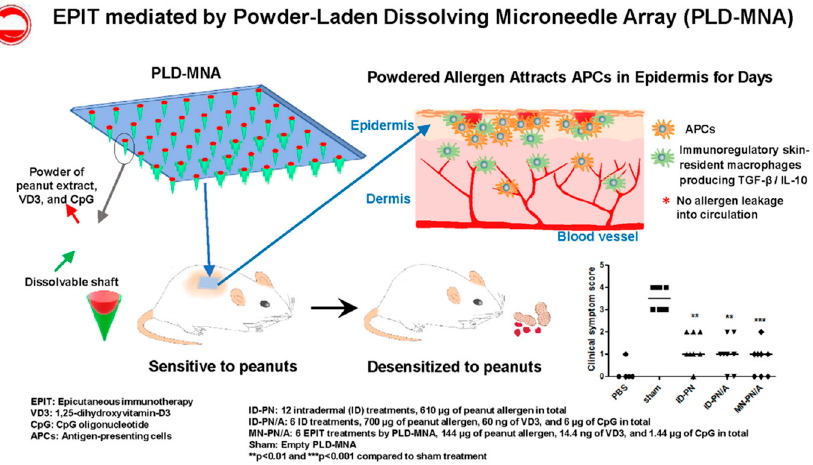
Figure 5. Schematic representation of the co-delivery strategy developed by Yu et al. for microneedle-mediated AIT. This image is reproduced with permission from reference [108]. Copyright© 2021, Elsevier.